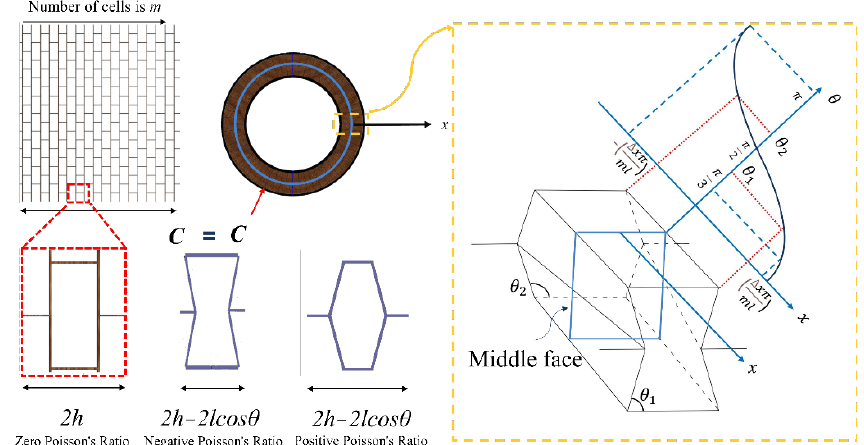
Figure 4. The cell of the core with variable Poisson ’ s ratio.